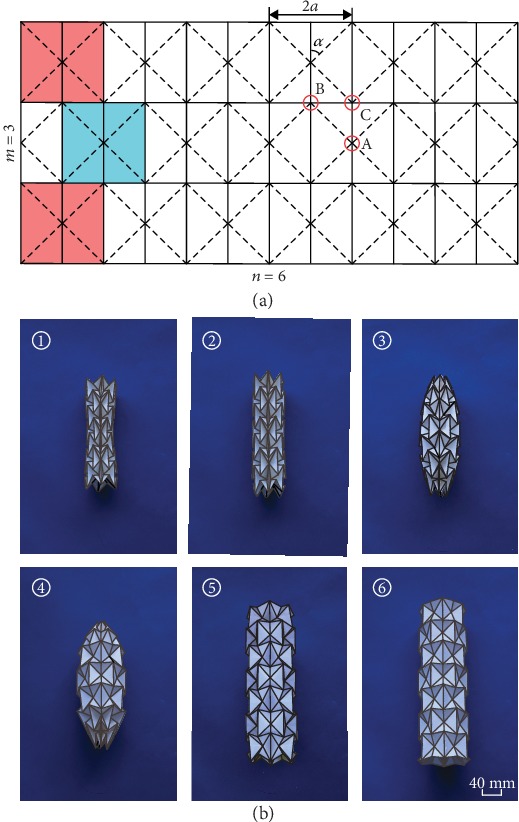
The waterbomb origami pattern and model. (a) The waterbomb pattern formed by tessellating the waterbomb bases. Solid and dashed lines represent mountain and valley creases, respectively. A typical base is shown in blue, which is placed side by side forming the middle row. On the adjacent rows, the bases are shifted by half a base (red). Four geometric parameters: width of the base 2a, sector angle α, the numbers of bases in the longitudinal direction m, and circumferential direction n—completely defining the pattern. A, B, and C are the three groups of representative vertices. (b) Deployment of a card model of a waterbomb tube. The model was made from conventional cards of 0.3 mm in thickness obtained from stationery stores. The geometric parameters were 2a = 46 mm, α = 45°, m = 7, and n = 6.